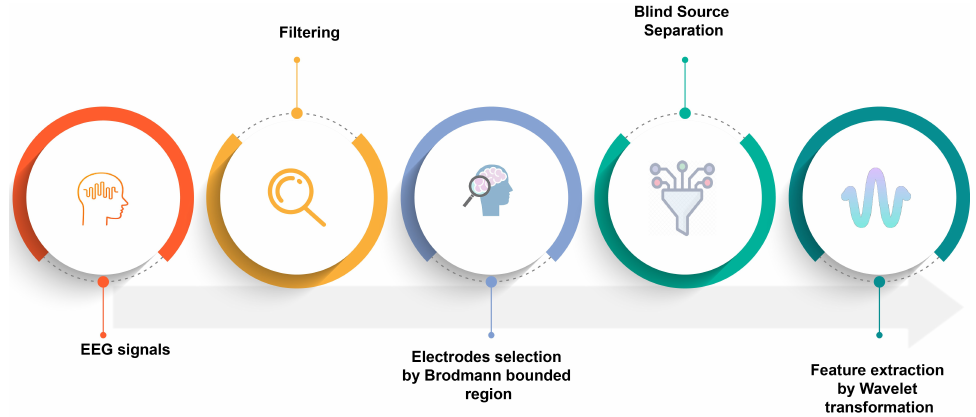
Figure 3. EEG analysis, treatment methodology, processing and feature